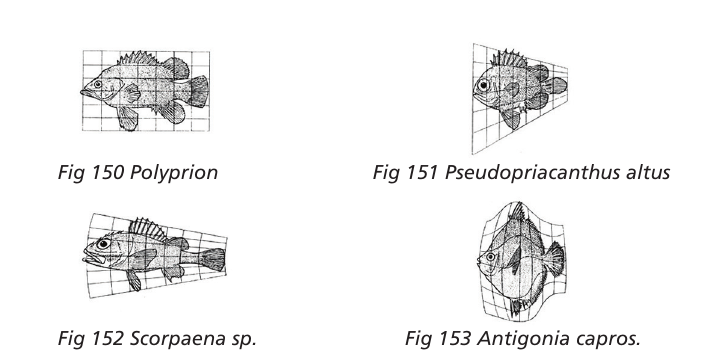
Fig 152 Scorpaena sp. Fig 153 Antigonia capros. Figure 18. D’Arcy Thompson described the differences in the forms of related animals using